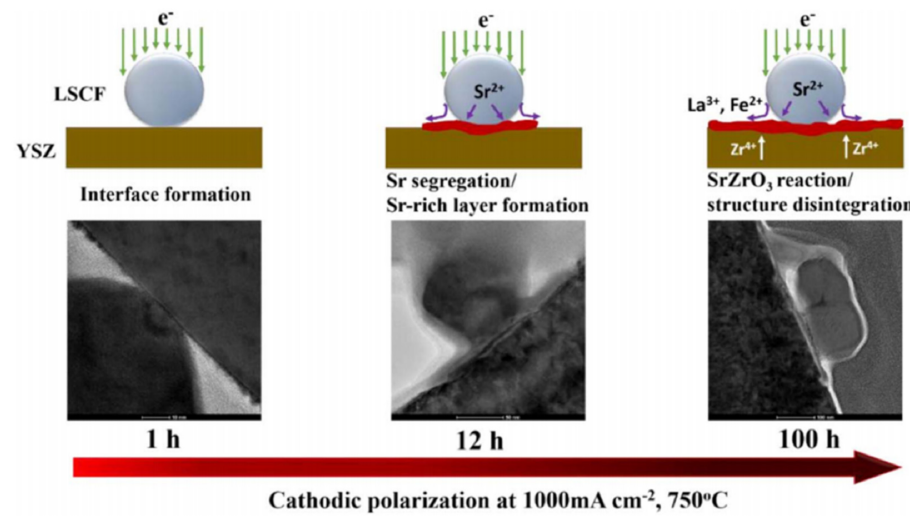
Figure 10. Scheme of the effect of polarization time on the Sr segregation and formation of SrZrO 3 phase at the LSCF/YSZ interface region [56] ( © The Electrochemical Society. Reproduced by permis- sion of IOP Publishing. All rights